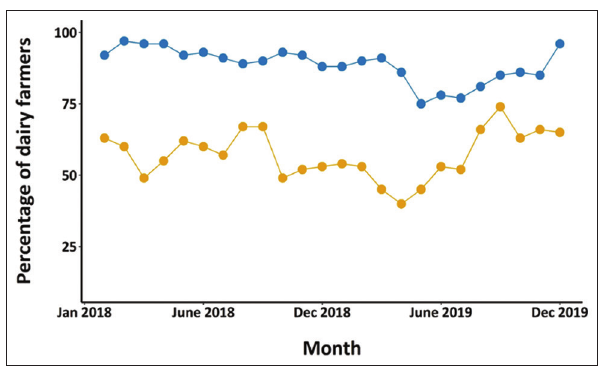
Figure-4: Monthly percentage of dairy farmers in the central (yellow dots) and northern (blue dots) regions gaining benefit from the milk payment